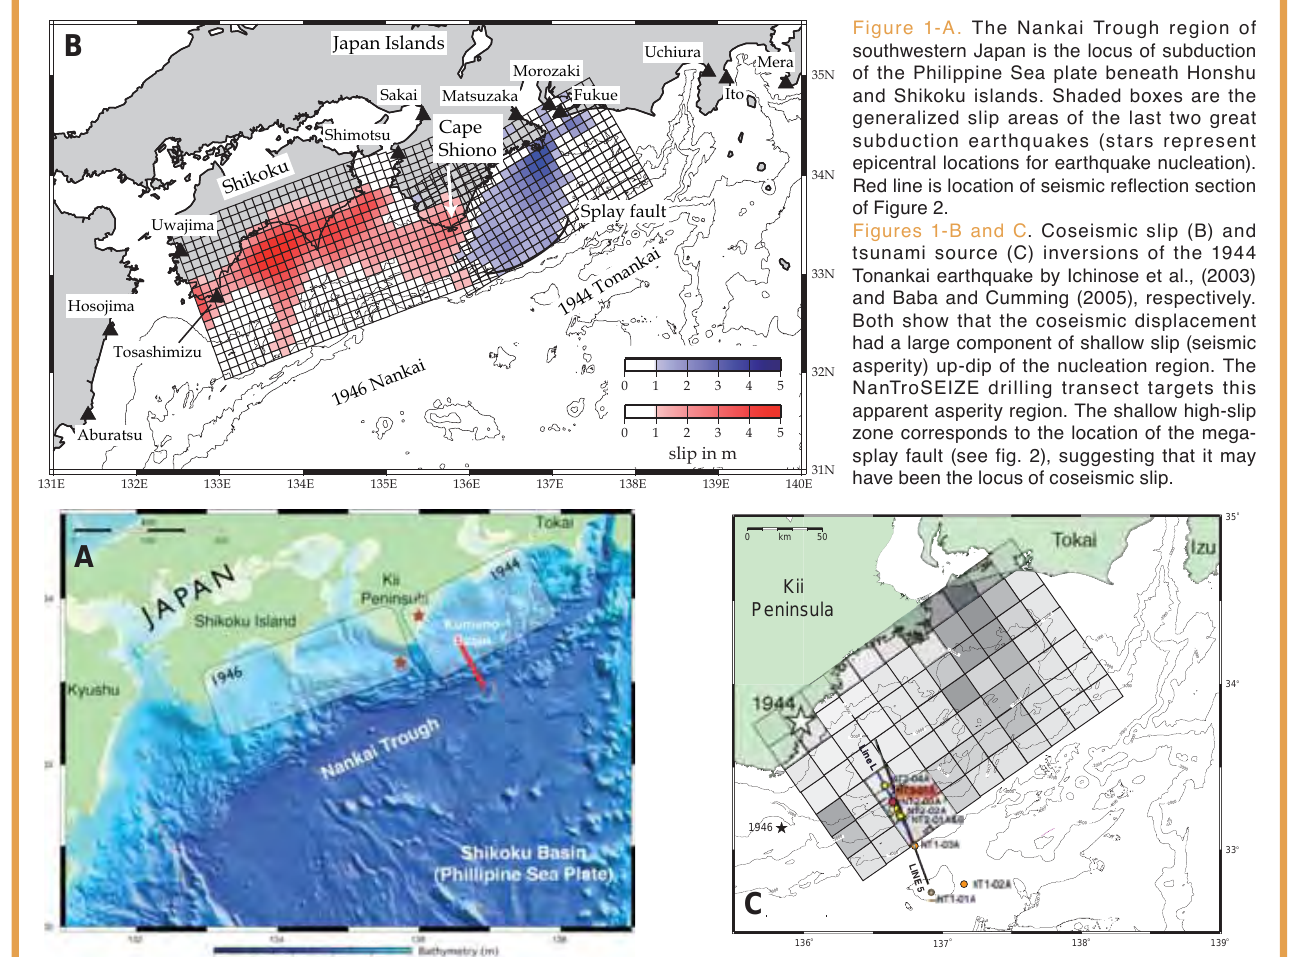
Figure 1-A. The Nankai Trough region of southwestern Japan is the locus of subduction of the Philippine Sea plate beneath Honshu and Shikoku islands. Shaded boxes are the generalized slip areas of the last two great subduction earthquakes (stars represent epicentral locations for earthquake nucleation). Red line is location of seismic re fl ection section of Figure 2. Figures 1-B and C. Coseismic slip (B) and tsunami source (C) inversions of the 1944 Tonankai earthquake by Ichinose et al., (2003) and Baba and Cumming (2005), respectively. Both show that the coseismic displacement had a large component of shallow slip (seismic asperity) up-dip of the nucleation region. The NanTroSEIZE drilling transect targets this apparent asperity region. The shallow high-slip zone corresponds to the location of the mega- splay fault (see fig. 2), suggesting that it may have been the locus of coseismic